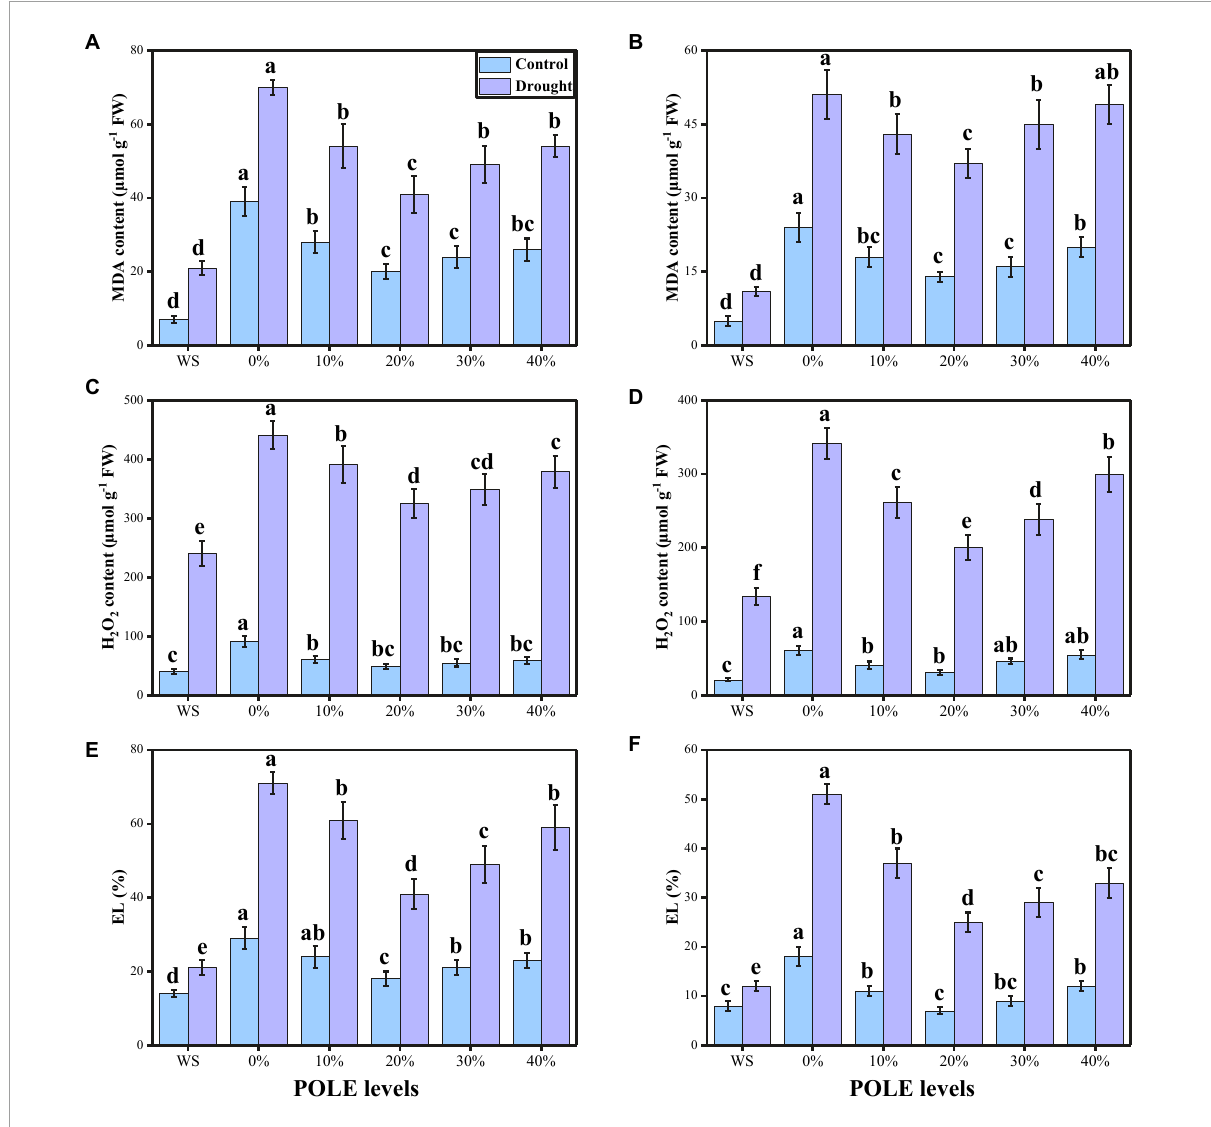
FIGURE5 Effect of seed priming with Plantago ovata Forsk leaf extract (POLE) on MDA contents in the roots (A) , MDA contents in the leaves (B) , H 2 O 2 contents in the roots (C) , H 2 O 2 contents in the leaves (D) , EL percentage in the roots (E) , and EL percentage in the leaves (F) under well-watered and drought-stressed environment in wheat. Means sharing similar letter(s) within a column for each parameter do not differ significantly at P < 0.05. Data in the figures are means of four repeats ( n = 4) of just one harvest of wheat plants ± standard deviation (SD). Different lowercase letters on the error bars indicate significant difference between the treatments. Different treatments of POLE used in this study are as follows: WS (Control, without POLE + without water), 0% (0% POLE), 10% (10% POLE), 20% (20% POLE), 30% (30% POLE), and 40% (40%